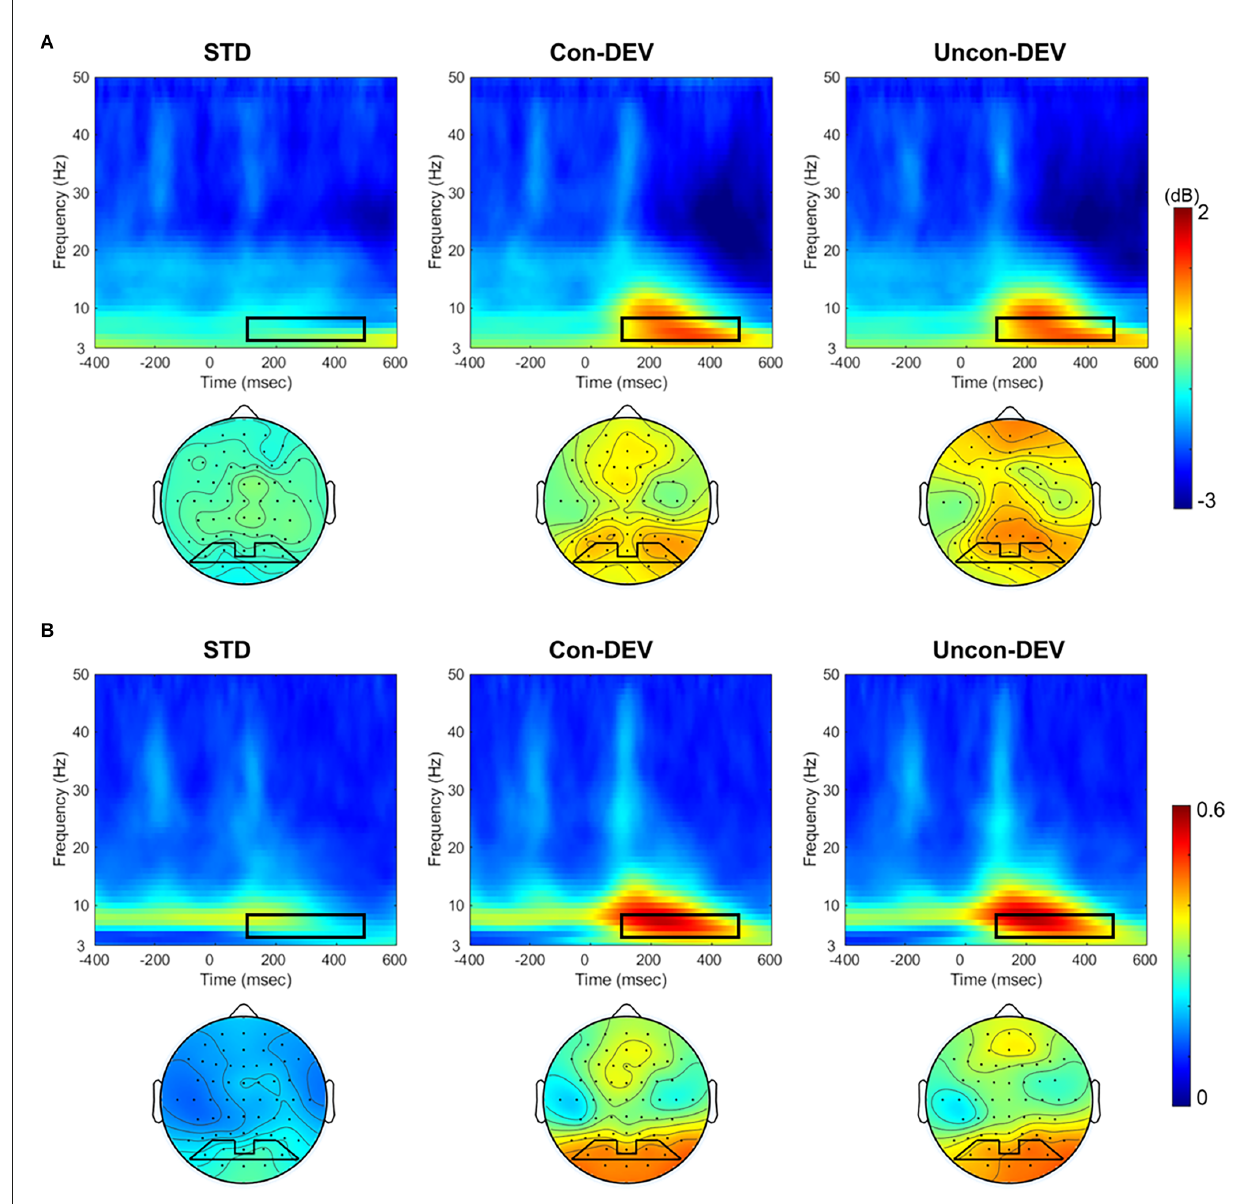
FIGURE2 ERSP and ITPC to the target image for each target condition. ERSPs (A) and ITPCs (B) at the posterior area (PO3, PO7, PO4, and PO8) and their isocontour maps averaged from 4 to 8 Hz at 100 to 500 ms are illustrated for each condition. ERSPs and ITPCs in both the Con-DEV and Uncon-DEV conditions were more enhanced than those in the STD condition in the time-frequency windows of 100–500 ms and 4–8 Hz. ERSP, event-related spectral perturbation; ITPC, inter-trial phase